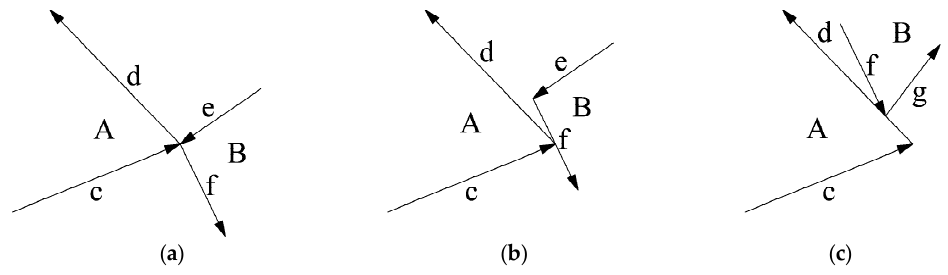
Figure 4. Three types of touching groups. ( a ) First type of touching group; ( b ) Second type of touching group; ( c ) Third type of touching group.